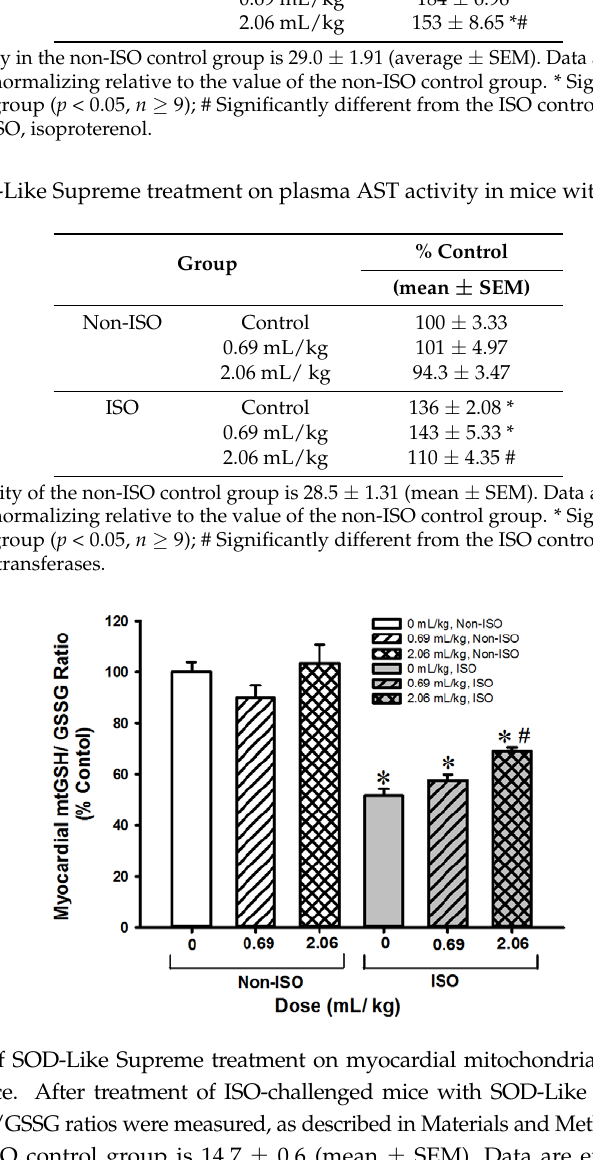
Table 3. Effects of SOD-Like Supreme treatment on plasma CK activity in mice with/without ISO challenge.